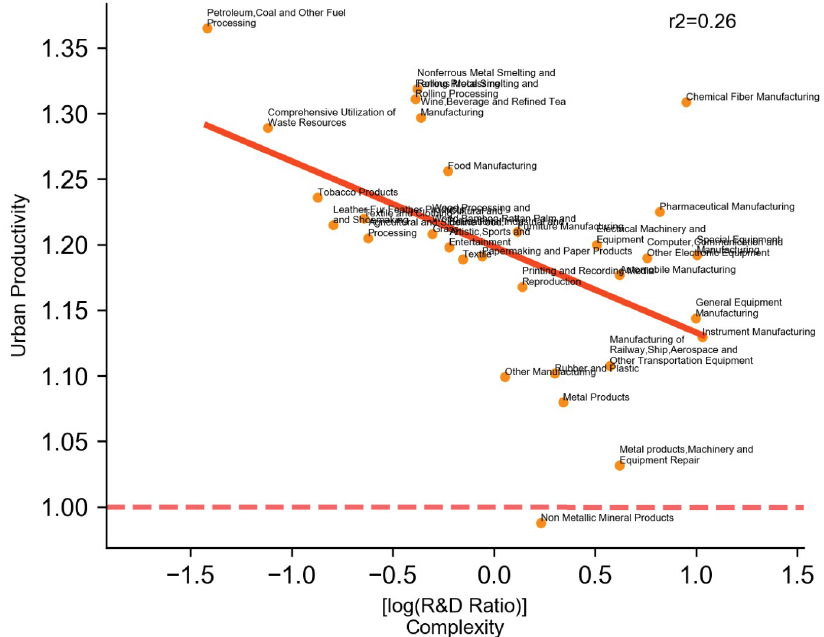
Fig 6. Complexity & urban productivity. Complexity is measured in the same way as in Fig 4. Urban Productivity is measured in the same way as in Fig 3.